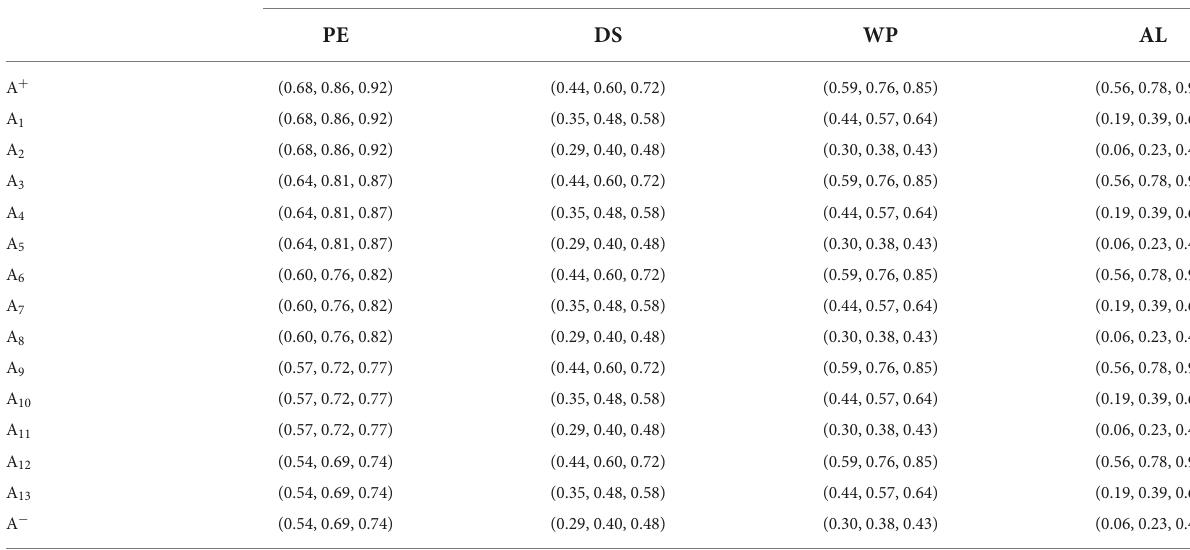
TABLE 9 The weighted normalized fuzzy decision matrix.